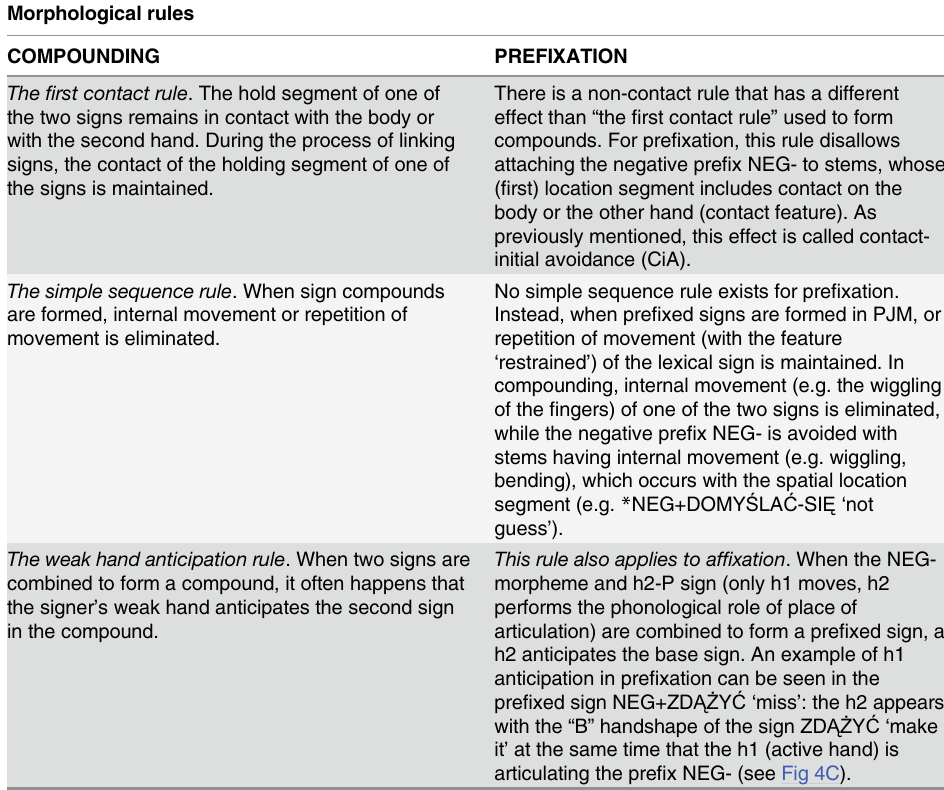
Table 4. Comparison of morphological constraints on sequential compounding and